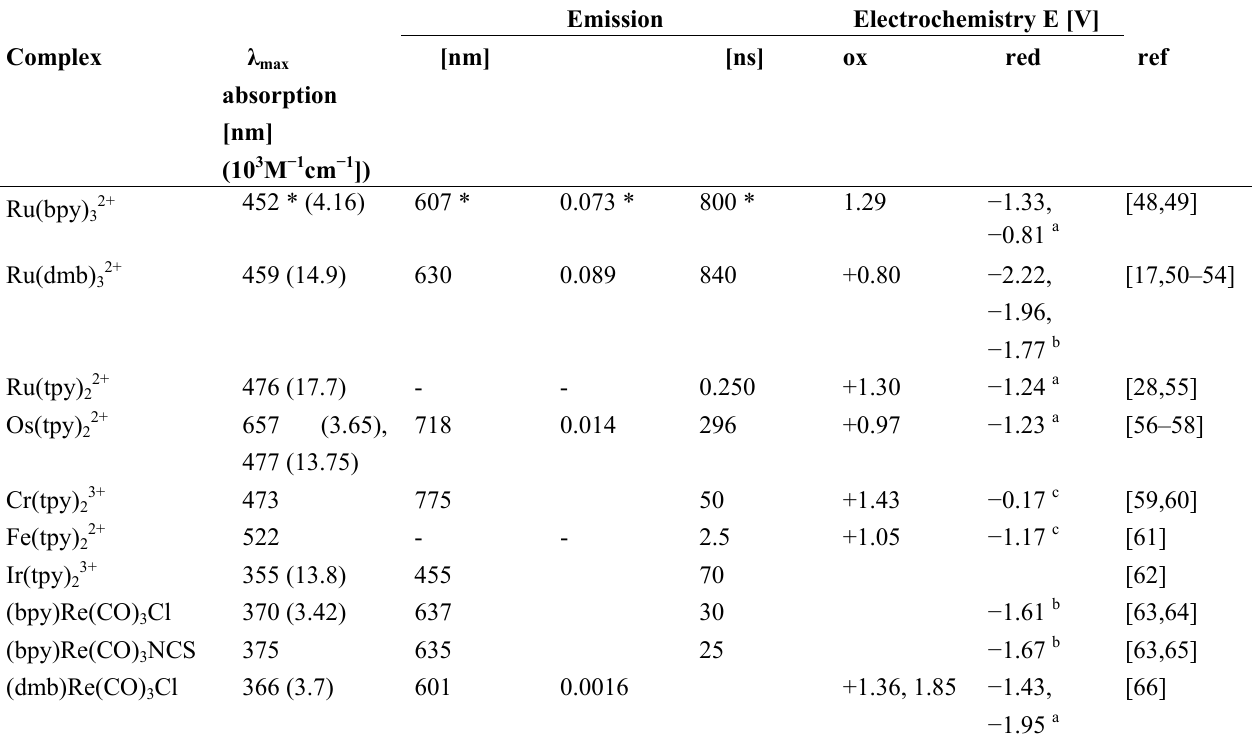
Table 1. Absorption, Luminescence and Electrochemical Data. Emission